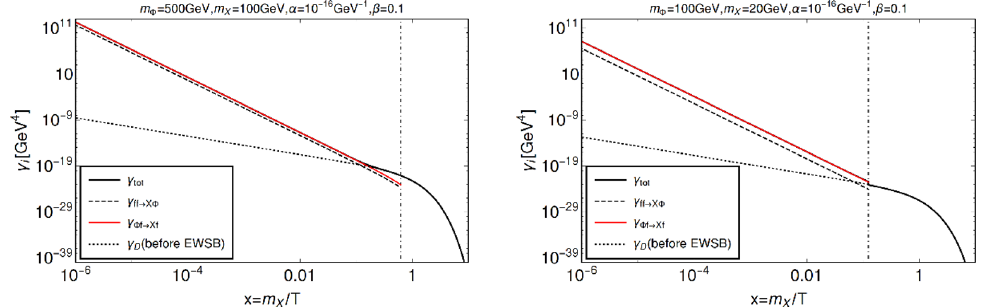
Figure 6 . Comparison of reaction densities ( γ ann,D ) for annihilation and the decay. Before EWSB we show the s -channel ¯ ff → X Φ process (black dashed) and t -channel Φ f → Xf (red) and also the decay contribution (black doted), while after EWSB we plot the density for the decay (solid black) only. The solid black line (hidden beneath the red line before EWSB) shows both contributions from the annihilation and the decay together. In the left panel we choose m Φ = 500 GeV , m X = 100 GeV, while in the right, we choose m Φ = 100 GeV , m X = 20 GeV. In both cases we have α = 10 − 16 GeV − 1 , β = 0 . 1 . The vertical dashed-dotted lines shows x corresponding to